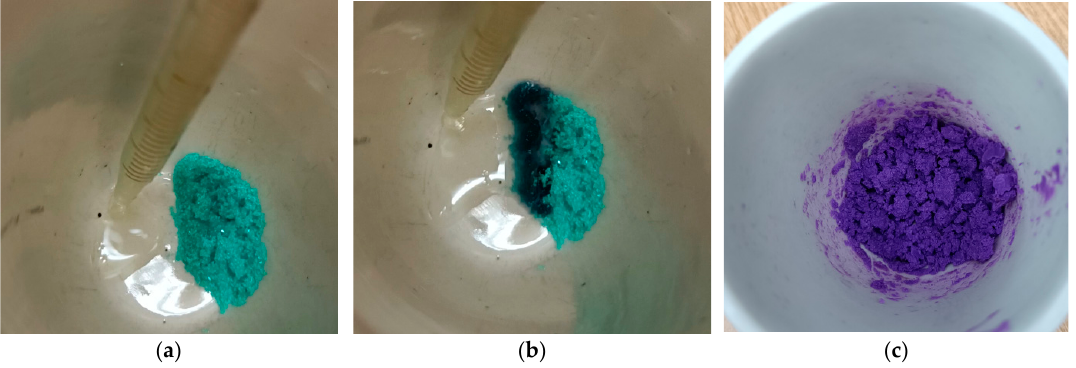
Figure 1. Synthesis of tris(ethylenediamine)nickel(II) nitrate without solvent: ( a ) initial state; ( b ) 0.5 min; ( c ) 2 min.